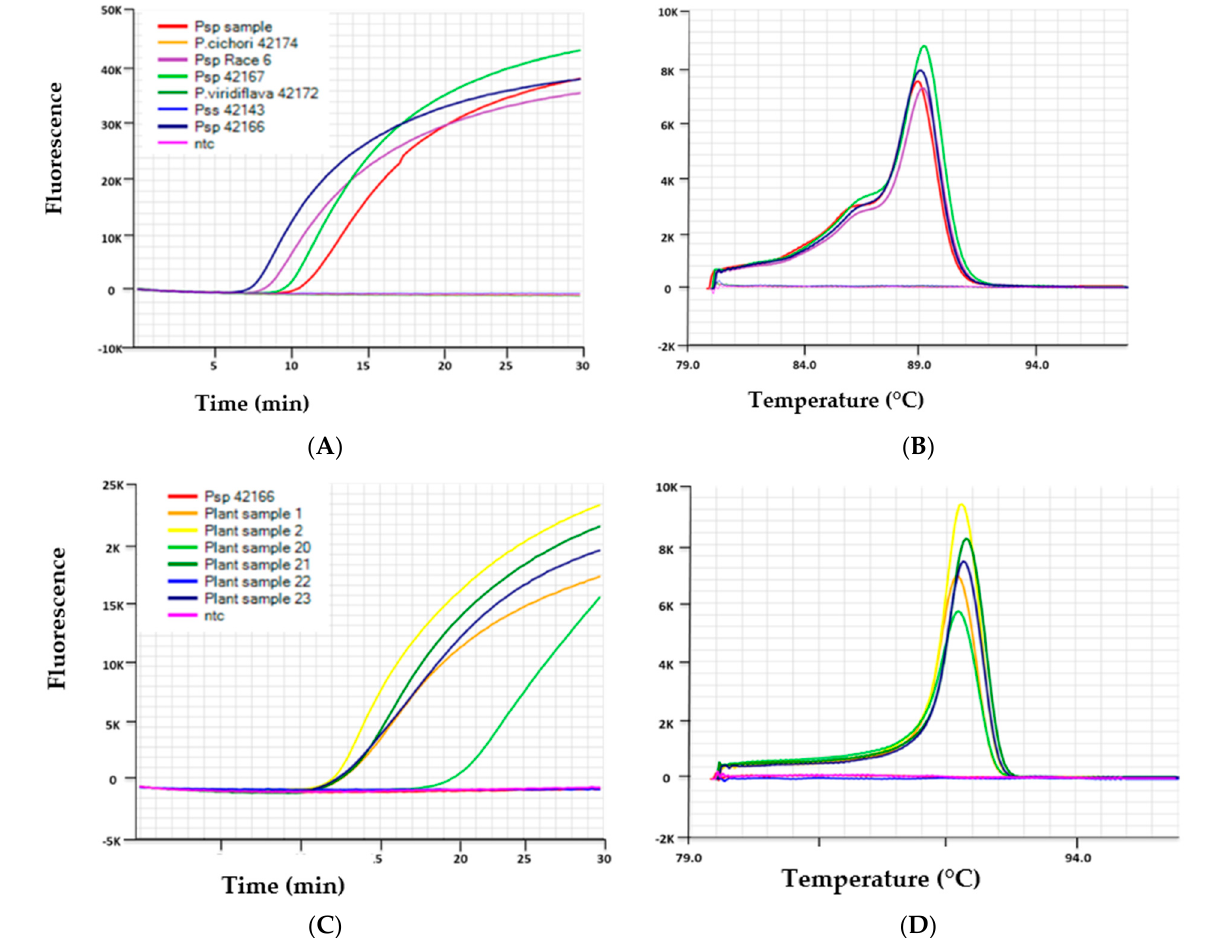
Figure 1. Results of LAMP assays shown as amplification curves ( A , C ) and melt curves ( B , D ) performed on Genie ® III with representative samples. ( A ): The Psp LAMP assay generated positive amplification curves from Psp isolates VPRI 42166 (Race 3), VPRI 42167 (Race 6), Psp plant sample, and no amplification (depicted by a flat line) from isolates of Pss VPRI 42143, P. viridiflava VPRI 42172 and P. cichorii VPRI 42174. ( B ): Melt curves produced anneal derivative from the positive samples of Psp with a range of 89.6–90.1 which is indicative of a positive result for this assay. ( C ): The Pss LAMP assay generated positive amplification curves from Pss positive plant samples 1, 2, 20, 21 and 23 and no amplification from Psp 42166 and ntc. ( D ): Melt curves produced from the positive samples of Pss with an anneal derivative range of 90.1–90.7, which is indicative of a positive result for this